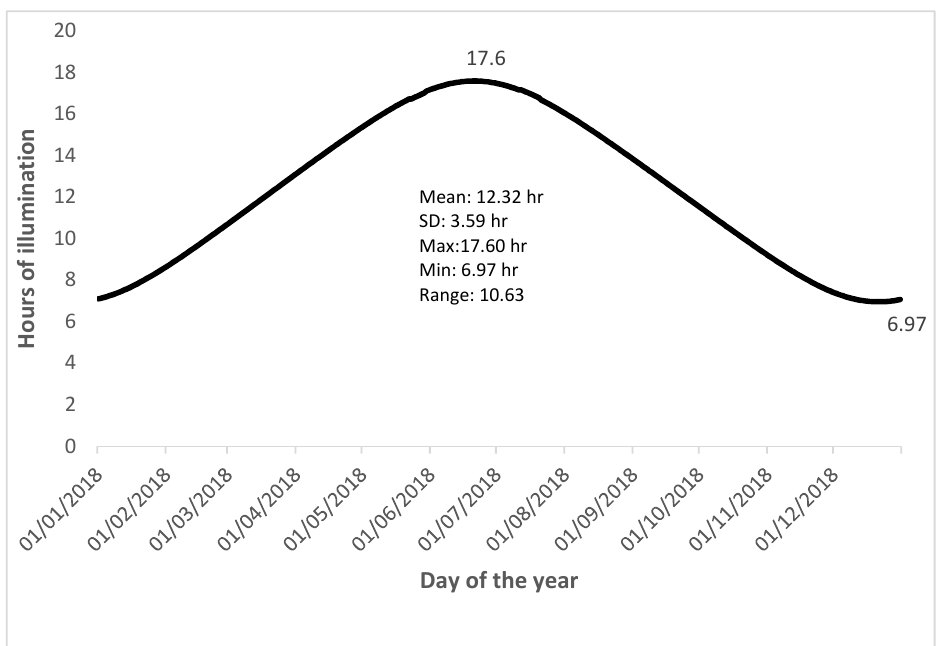
Figure 1. Hours of daylight illumination during 2018 in Saskatchewan.